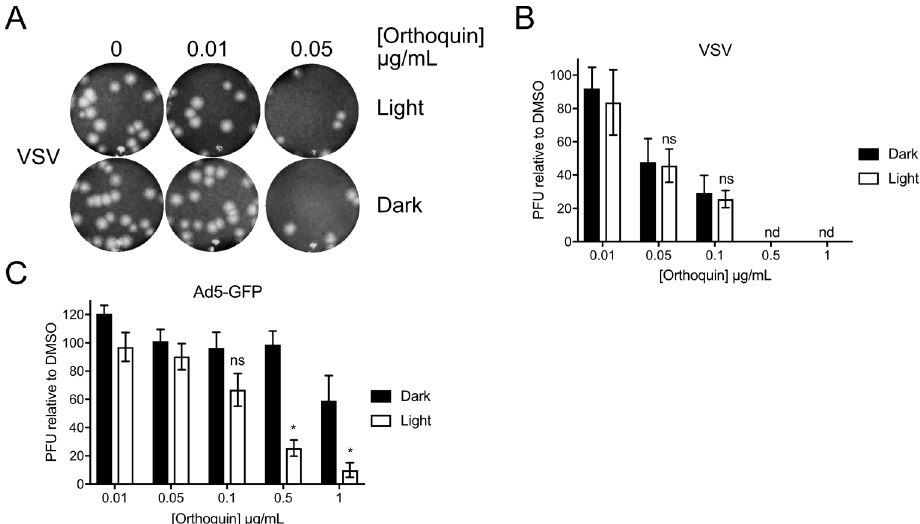
Figure 9. Orthoquin inhibits vesicular stomatitis virus (VSV) and human adenovirus type 5 (AdV) plaque formation. ( A ) VSV inocula were mixed with Orthoquin at concentrations ranging from 0.01 to 1 µ g/mL and exposed to a 65 W LED light in clear (light) or black (dark) tubes for 5 min. Treated inocula were then plaqued on a monolayer of Vero cells, as described in the methods. A representative image of VSV plaques is shown. ( B ) Quantification of plaques in ( A ). Values were normalized to the number of PFUs detected in DMSO, light or dark treated wells. n = 3 ± SEM from three independent biological replicates. ( C ) AdV inocula were mixed with Orthoquin at concentrations ranging from 0.01 to 1 µ g/mL and exposed to a 65 W LED light in clear (light) or black (dark) tubes for 10 min. Treated-inocula were then plaqued on monolayers of HEK293A cells, as described in the methods. Plaques were counted using a fluorescent microscope. n = 4 ± SEM from four independent biological replicates. * = p < 0.05 by two-way ANOVA. ns = non-significant by two-way ANOVA. nd = none detected.